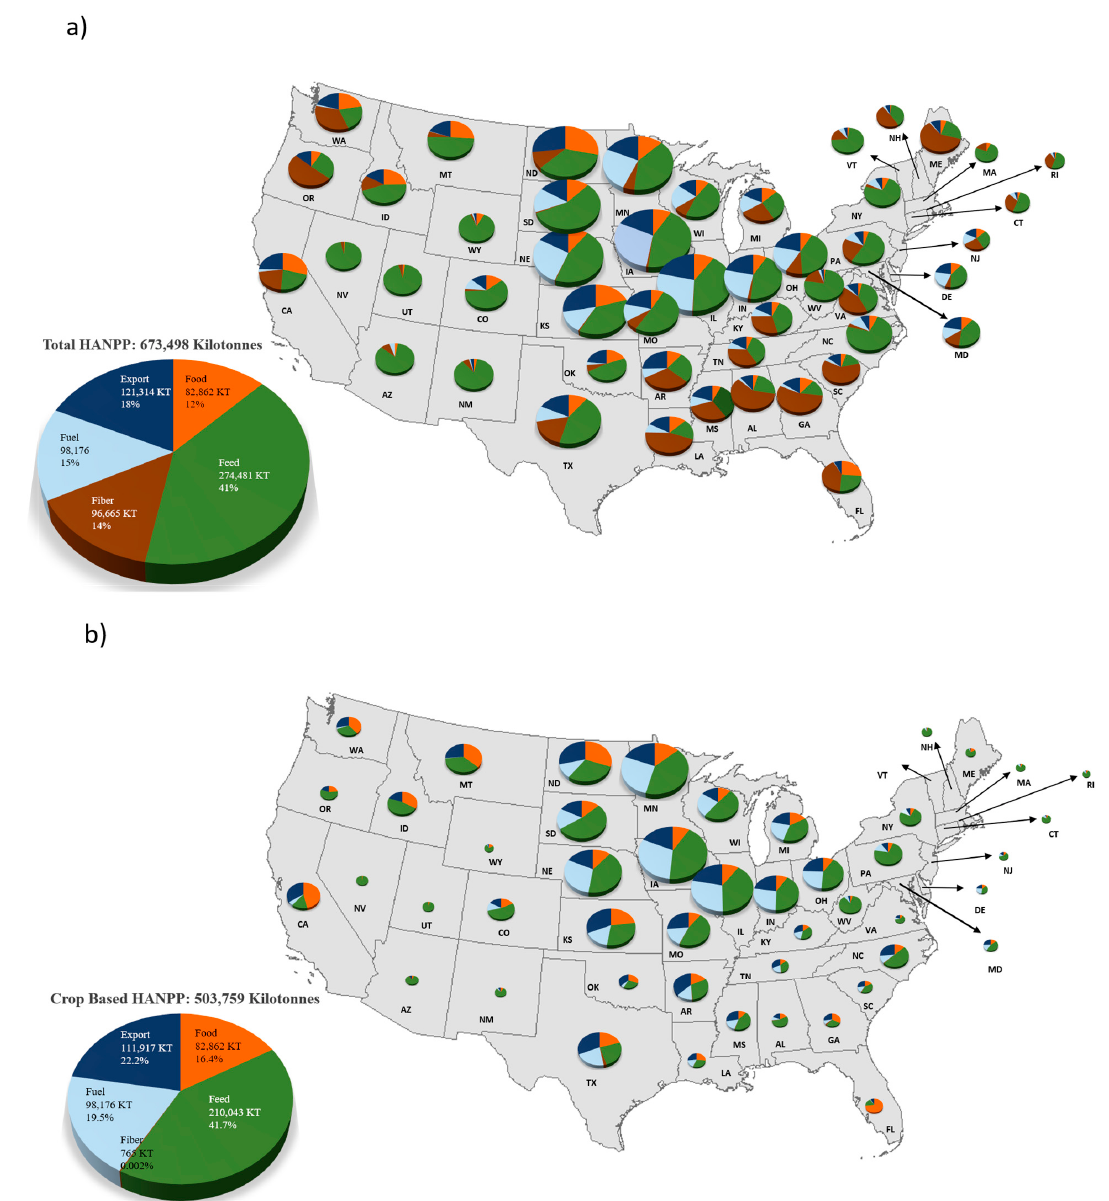
Figure 4. Geographic distribution among the 48 contiguous states in 2012 in ( a ) total HANPP (harvest) and ( b ) crop-based HANPP and the proportions allocated to human food, livestock feed, biofiber, biofuel and exports.